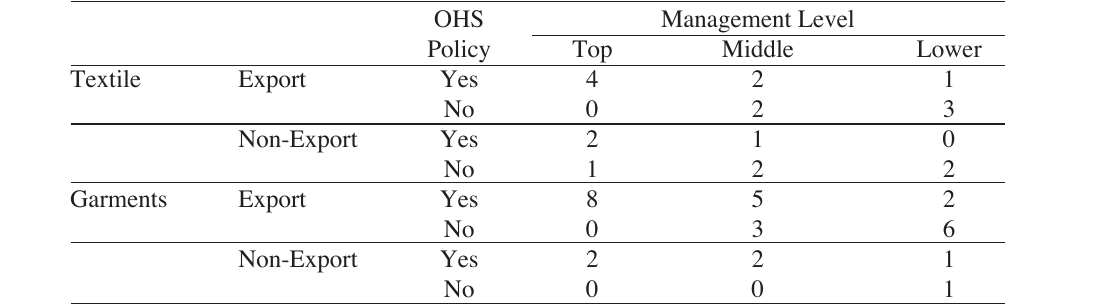
Cross-tabulation between Management Position and OHS Policy Implementation